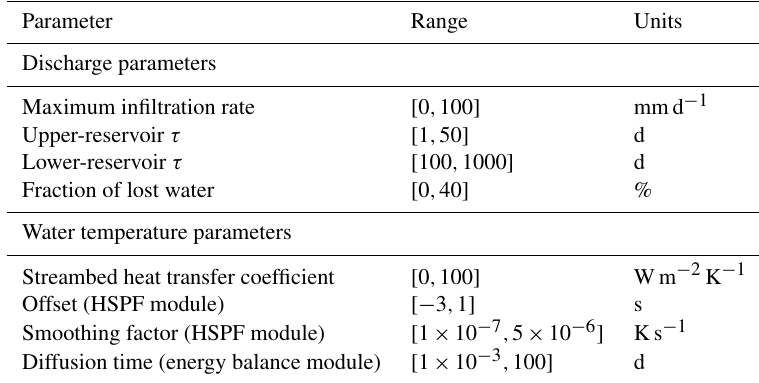
Table 3. Calibration parameters and range of values used in StreamFlow; see Gallice et al. (2016) for details. Parameter